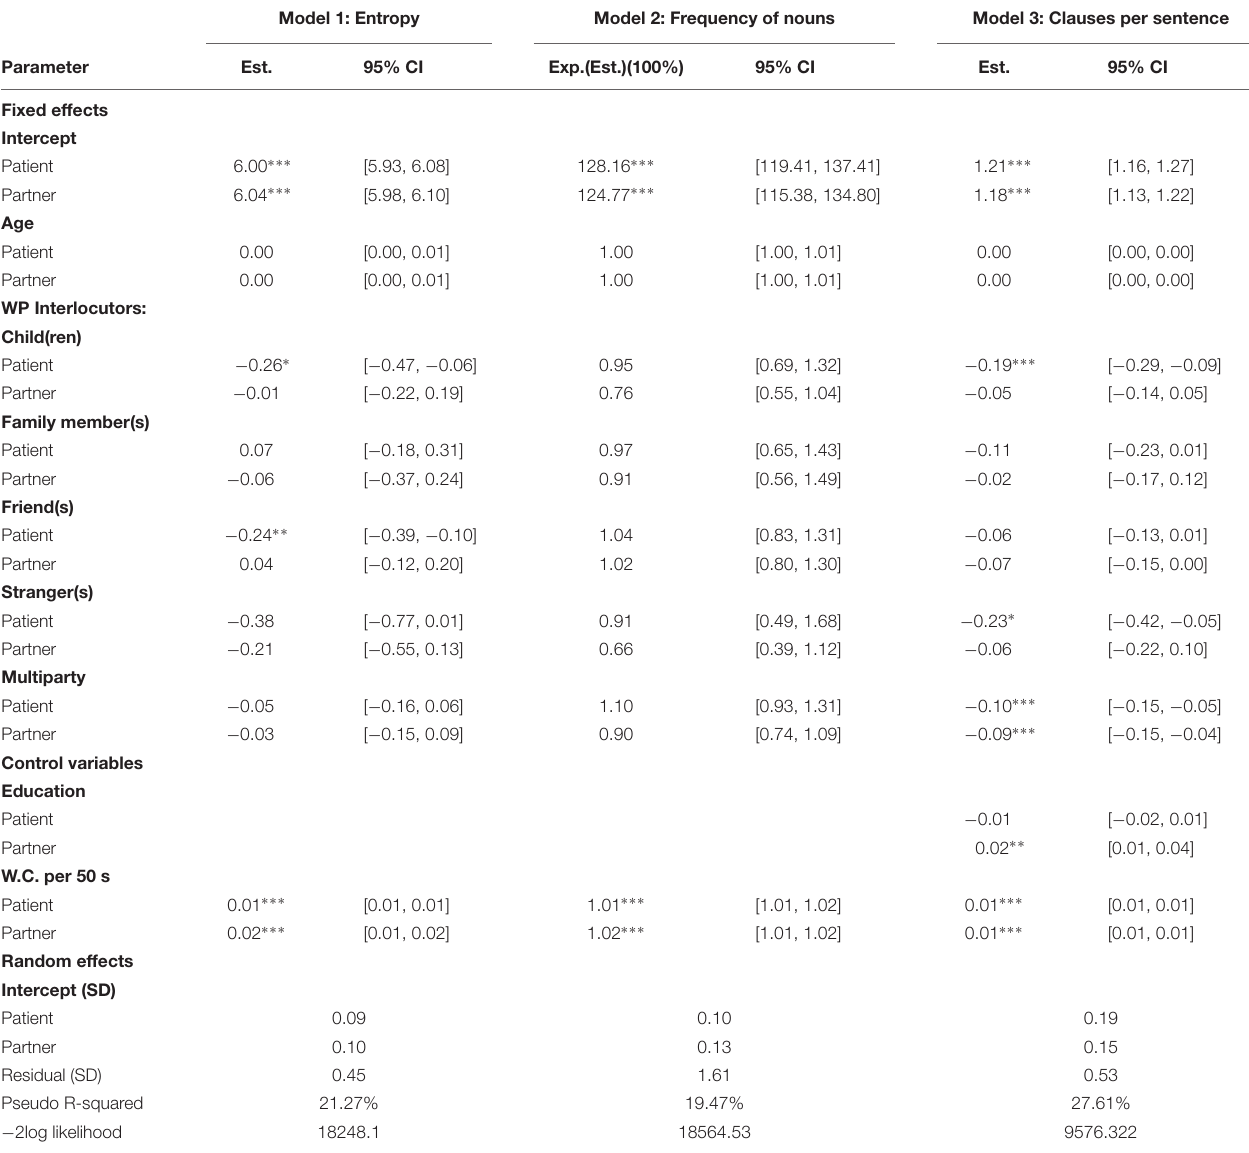
TABLE 3 | Two-intercept models on language use. Model 1: Entropy Model 2: Frequency of nouns Model 3: Clauses per